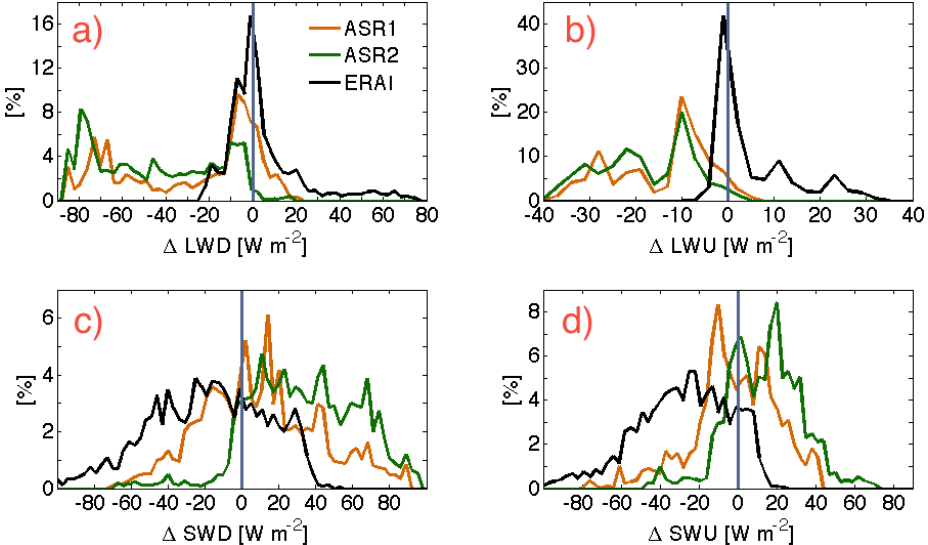
Fig. 13. Histograms (%) of the difference between each reanalysis and the ASCOS observations for the variables in Fig. 12: (a) downward longwave (LWD), (b) upward longwave (LWU), (c) downward shortwave (SWD) and (d) upward shortwave radiation (SWU), all in Wm − 2 .